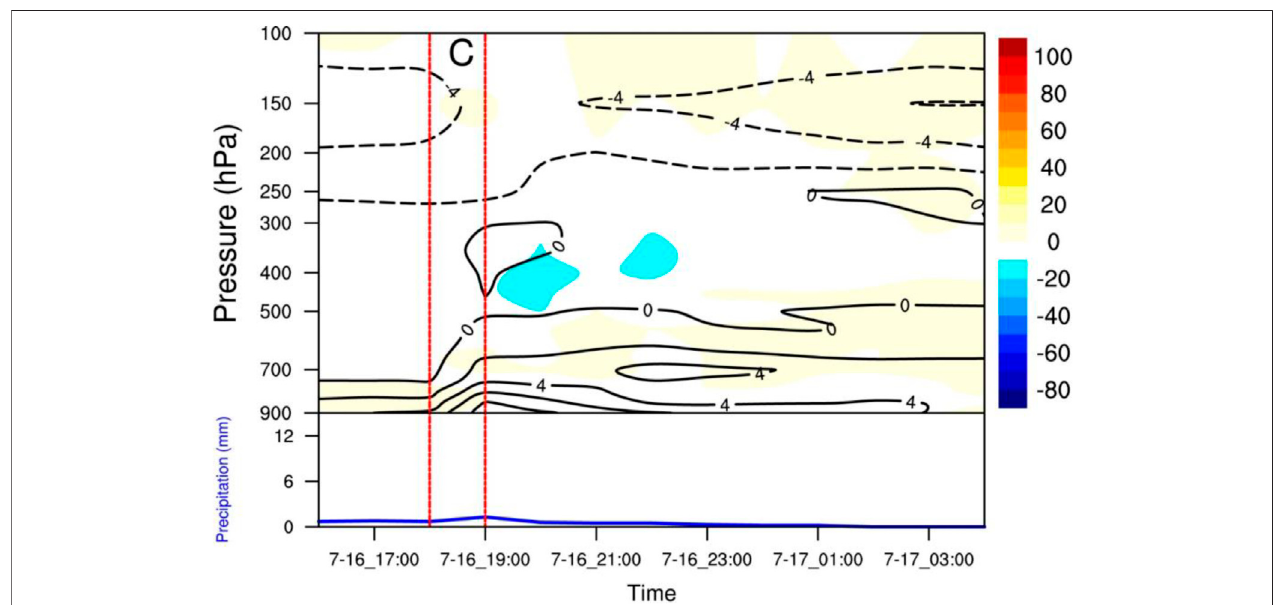
FIGURE12 | Time – pressure sections ofapparentheat source Q1(K day − 1 , shaded), relativevorticity (10 − 5 s − 1 , black contours), and regionalmeanprecipitation in the key region of C (mm, blue line) from 16:00 UTC July 16 to 04:00 UTC July 17 by the NOLH experiment.